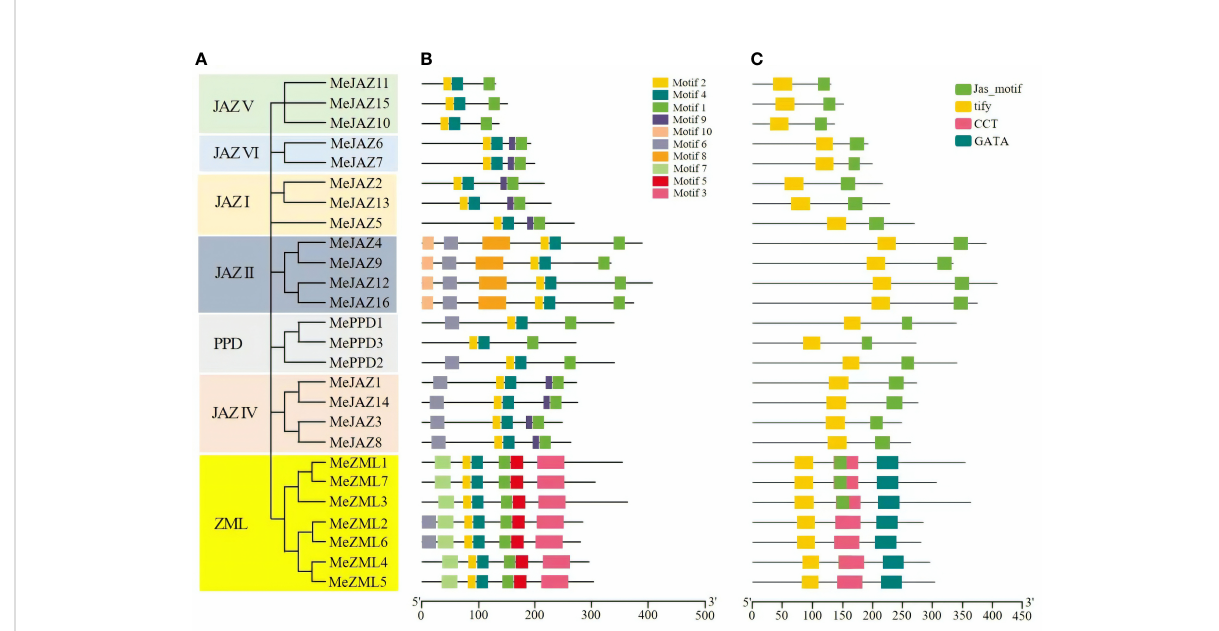
FIGURE 2 Phylogenetic relationships, conserved motifs and conserved domains of the predicted cassava JAZ, PPD, and ZML proteins. (A) The phylogenetic tree of cassava JAZ, PPD, and ZML proteins constructed with the Neighbor-joining (NJ) method in MEGA 7.1. The bootstrap values were 1,000 replications for major branches. The genes in seven subgroups were marked with different colors. (B) Different motif compositions of cassava JAZ, PPD, and ZML proteins were detected using MEME. The boxes with different colors on the right denote 10 motifs. A detailed motif introduction is shown in Supplementary Table S7. (C) Conserved domains in the cassava ZML, PPD and JAZ proteins. Different domains were shown in different